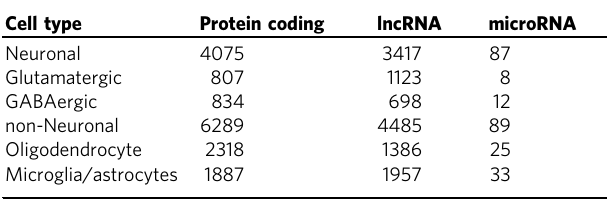
Table 1 Cell-speci fi c transcripts identi fi ed from open